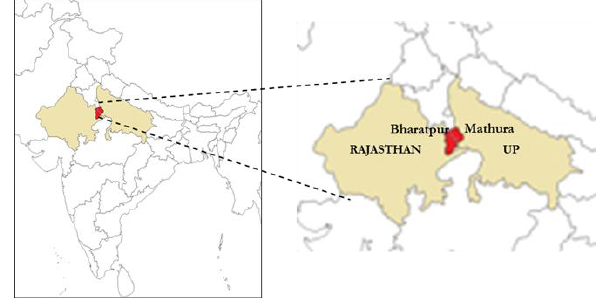
Figure 1. Location of the study area